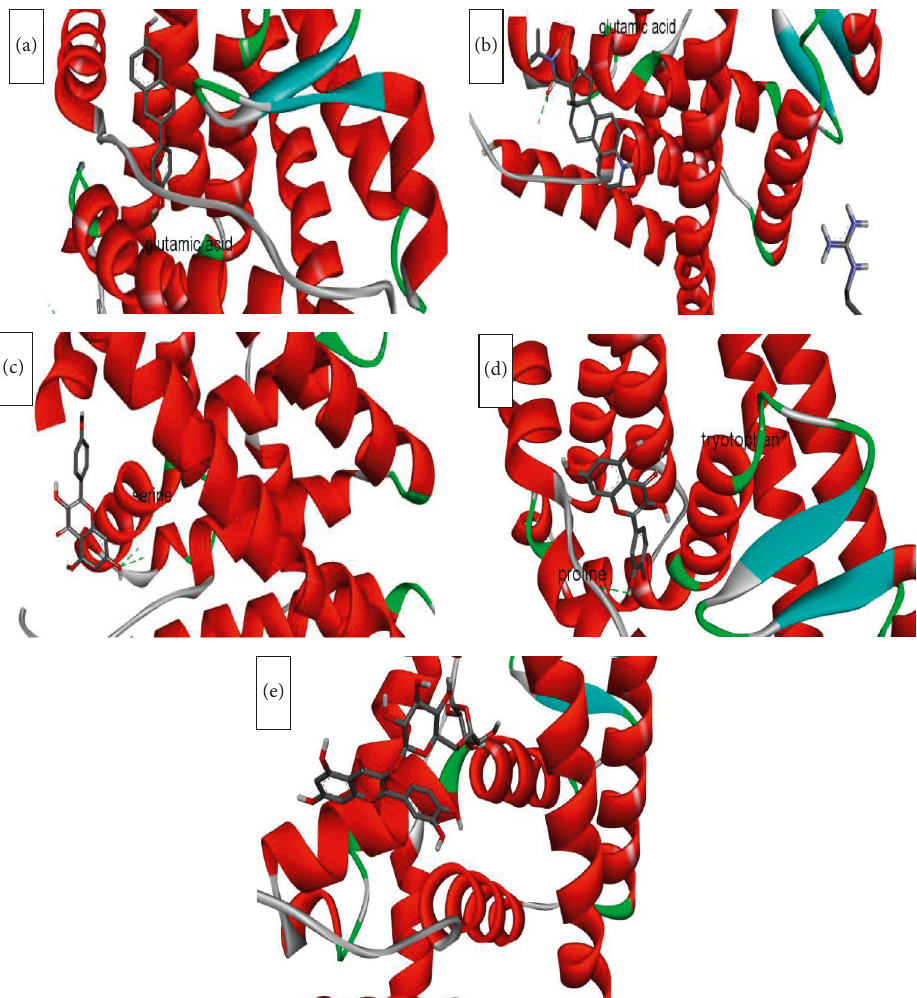
Figure 8: Interaction between amino acids in the binding site of ER-b enzyme, and (a) � equol, (b) � finasteride, (c) � kaempferol, (d) � quercetin, and (e) � rutin, respectively. The green bonds show intermolecular hydrogen bonds. Glutamic acid, serine, tryptophan, and proline from ER-b enzyme are involved in H-bond interaction with